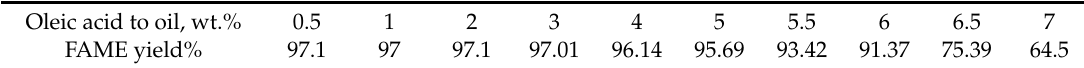
Table 1. The effect of free fatty acid (FFA) in feedstock on the percentage of fatty acid methyl esters (FAME) yield. Oleic acid to oil, wt.%